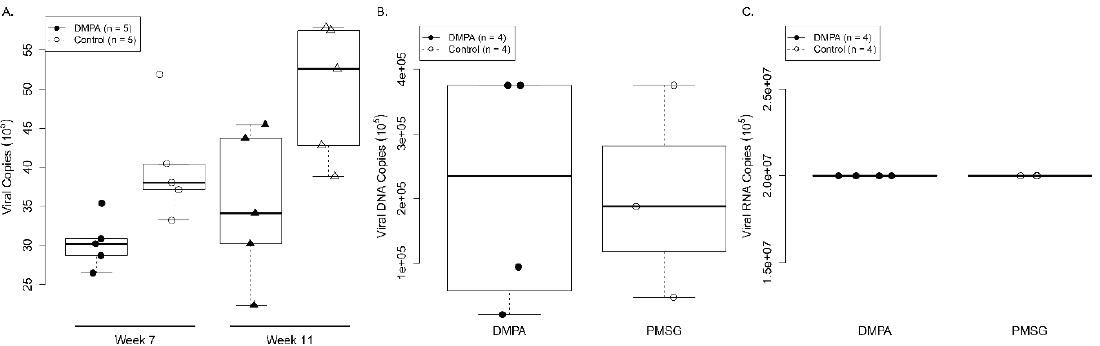
Figure 4. No significant difference in viral load was detected in the lower genital tract of Depo medroxyprogesterone (DMPA) treated ovariectomized Nu/J heterozygous (Foxn1 nu/+ ) mice. Nu/J heterozygous (Foxn1 nu/+ ) ovariectomized mice were distributed into two groups ( n = 5 per group) and treated with DMPA or PMSG three days before viral infection at vaginal and anal sites. Viral DNA was detected by collecting vaginal lavage samples followed by qPCR analysis at different time points post infection. No significantly higher levels of viral DNA ( A ) copies were detected in DMPA treated mice when compared to those in PMSG treated mice ( p > 0.05, Wilcoxon rank sum tests). No significantly higher levels of viral DNA ( B ) and viral RNA ( C ) copies were detected in DMPA treated vaginal tissues when compared to those in PMSG treated mice ( p > 0.05, Wilcoxon rank sum tests).